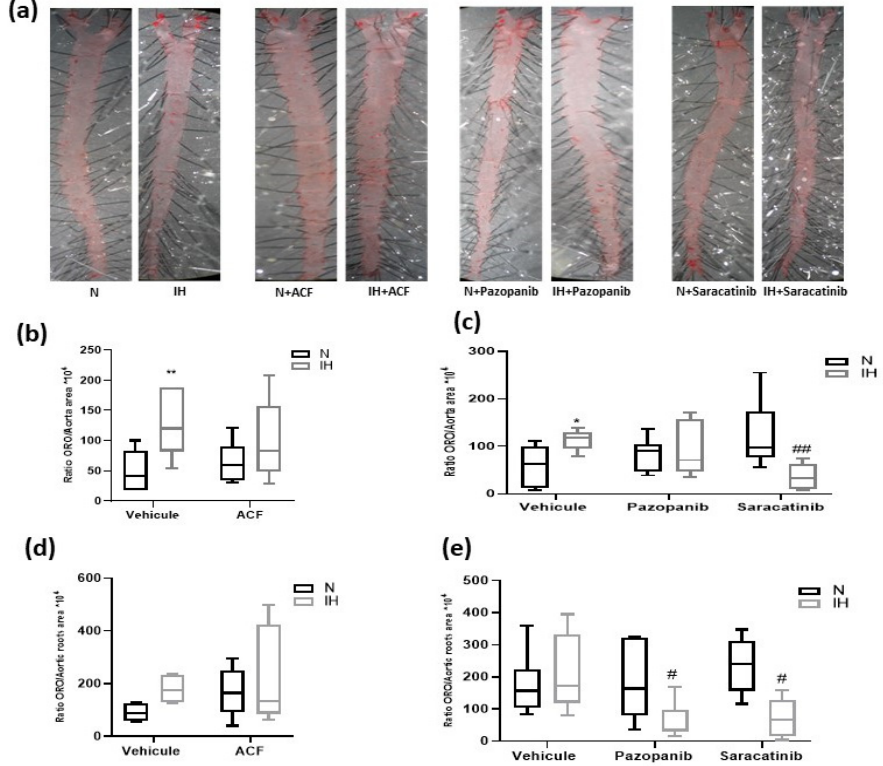
Figure 5. The impact of the inhibition of VE-cadherin cleavage pathways on atherosclerosis lesions in ApoE-/- mouse aortas. ( a ) Representative examples of ORO-stained entire aortas. ( b ) Inhibiting HIF-1 (by ACF) prevented atherosclerotic plaques in aortas of ApoE-/- mice exposed for 8 weeks to IH (Kruskal-Wallis test, ** p < 0.01 vs. N + vehicle, n = 5–8). ( c ) Inhibition of VEGFR tyr-kinases (by pazopanib) and src-kinases (by saracatinib) prevented the formation of atherosclerotic plaques in aortas of ApoE-/- mice exposed for 8 weeks to IH (Kruskal-Wallis test, * p < 0.05 vs. N + vehicle, ## p < 0.01 vs. IH + vehicle, n = 5–6). ( d ) Inhibiting HIF-1 (by ACF) tended to reduce atherosclerotic plaques in aortic roots of ApoE-/- mice exposed for 8 weeks to IH (Kruskal-Wallis test, p = 0.08 for N + vehicle vs. IH + vehicle, n = 4–8). ( e ) Inhibition of VEGFR tyr-kinases (by pazopanib) and src- kinases (by saracatinib) reduced the atherosclerotic plaque area in aortic roots of ApoE-/- mice ex- posed for 8 weeks to IH (Kruskal-Wallis test, # p < 0.05 vs. IH + vehicle, n = 5–6). N: normoxia, IH: intermittent hypoxia. Values are median + interquartile range. 2.5. Inhibiting VEGRF Tyr-Kinases or Src-Kinases Abolishes the IH-Induced Increase in Arterial Blood Pressures in ApoE-/- Mice We measured arterial blood pressure by tail-cuff sphygmomanometry in ApoE-/- mice after 8 weeks of exposure to IH. We found that IH increased arterial systolic, diastolic and mean blood pressures, in accordance with the literature, and the VEGFR-tyrosine ki- nases and Src-tyrosine kinases inhibitors (pazopanib and saracatinib, respectively) pre- vented this effect (Figure 6a). In the groups intraperitoneously injected with drugs (DMSO or acriflavine), the hypertensive effect of IH did not reach the significance level and only trends were observed regarding the preventive effects of acriflavine (Figure 6b).